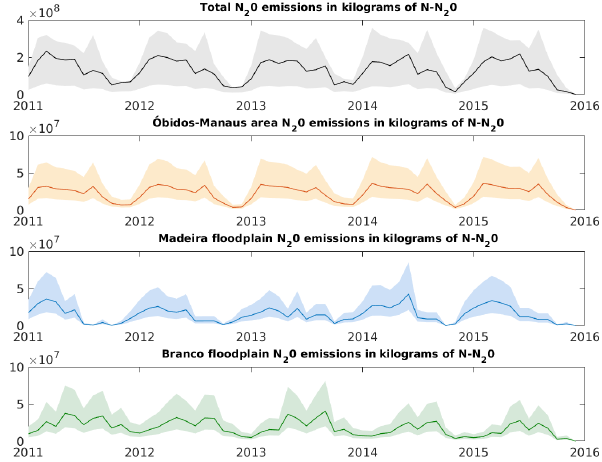
Figure 6. Monthly time series of N 2 O emissions over the basin (black), for the O–M FP (orange), for the Madeira FP (blue) and for the Branco FP (green) over the period (2011–2015). The lines repre- sent the emissions for a N 2 O / N 2 ratio of 0.1, whereas the coloured areas refer to the potential range of the ratio (0.05–0.2). Denitrifi- cation and CO 2 emissions follow the same patterns but with a scale factor of times 10 for denitrification and times 2 for CO 2